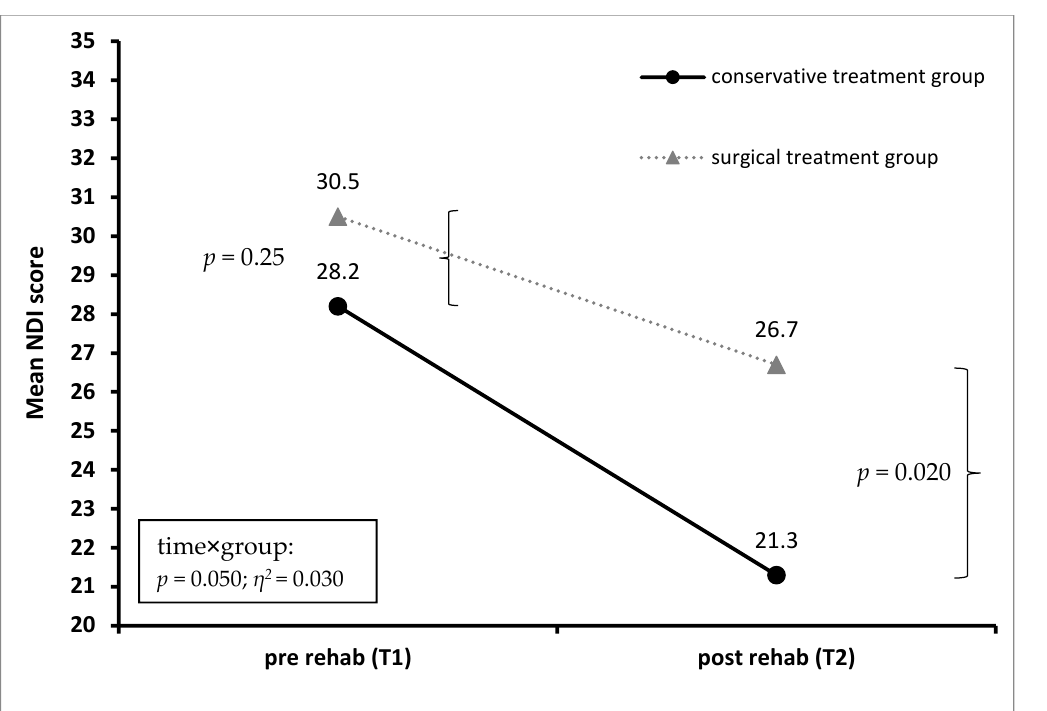
Figure 3. Mean Neck Disability Score (NDI) before ( T 1) and after ( T 2) rehabilitation treatment for patients in the conservative and the surgical treatment group.